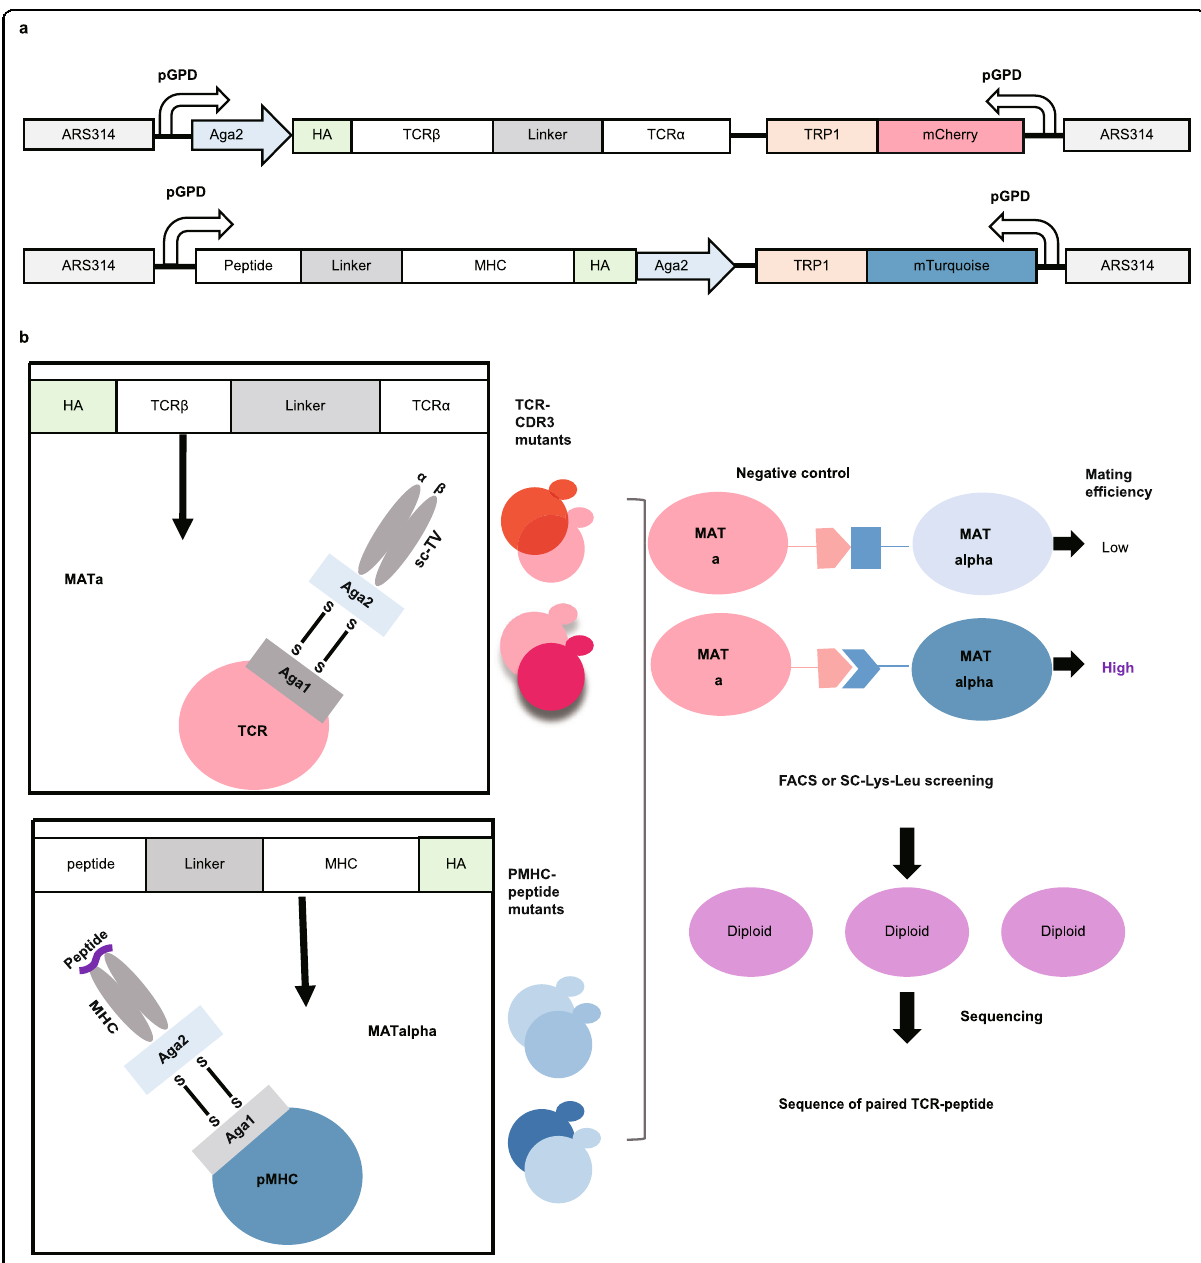
Fig. 1 Schematic overview of the YAMTAD system. a Schematic diagram of the strategy used for constructing the TCR and pMHC cassettes. The TCR cassette was constructed by connecting the variable domains of the TCR with a fl exible linker. The pMHC cassette features an N-terminal peptide library linked to wild-type β -2-microglobulin ( β 2M), followed by the HLA heavy chain. TCR and pMHC cassettes are tethered to an epitope tag and Aga2p driven by the constitutive GPD promoter (pGPD). TCR and pMHC cassettes and mating-type-speci fi c fl uorescence reporters (mCherry and mTurquoise) were integrated into the ARS314 site of MATa or MATalpha yeast, respectively, using TRP1 as the selection marker. b Schematic overview of the YAMTAD system. TCR and pMHC cassettes were displayed on MATa and MATalpha yeast cell surfaces by binding to the Aga1 protein. MATa and MATalpha have complementary leucine and lysine auxotrophic markers for diploid selection. Mating is induced when a TCR displayed on MATa yeast recognizes cognate pMHC displayed on MATalpha yeast. The diploids expressing the double fl uorescence can be sorted by FACS or SC-Lys-Leu screening for identi fi cation of the peptide and TCR sequences in them by next-generation